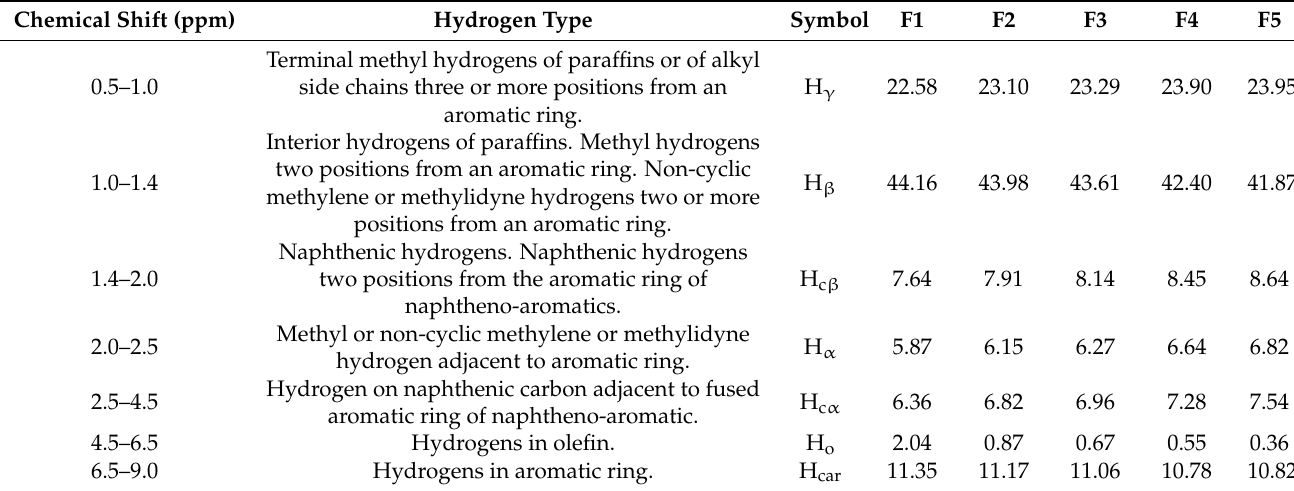
Table 3. Hydrogen type distribution in the 1 H-NMR spectra of FCC slurry oil before and after hydrotreatment. Chemical Shift (ppm)